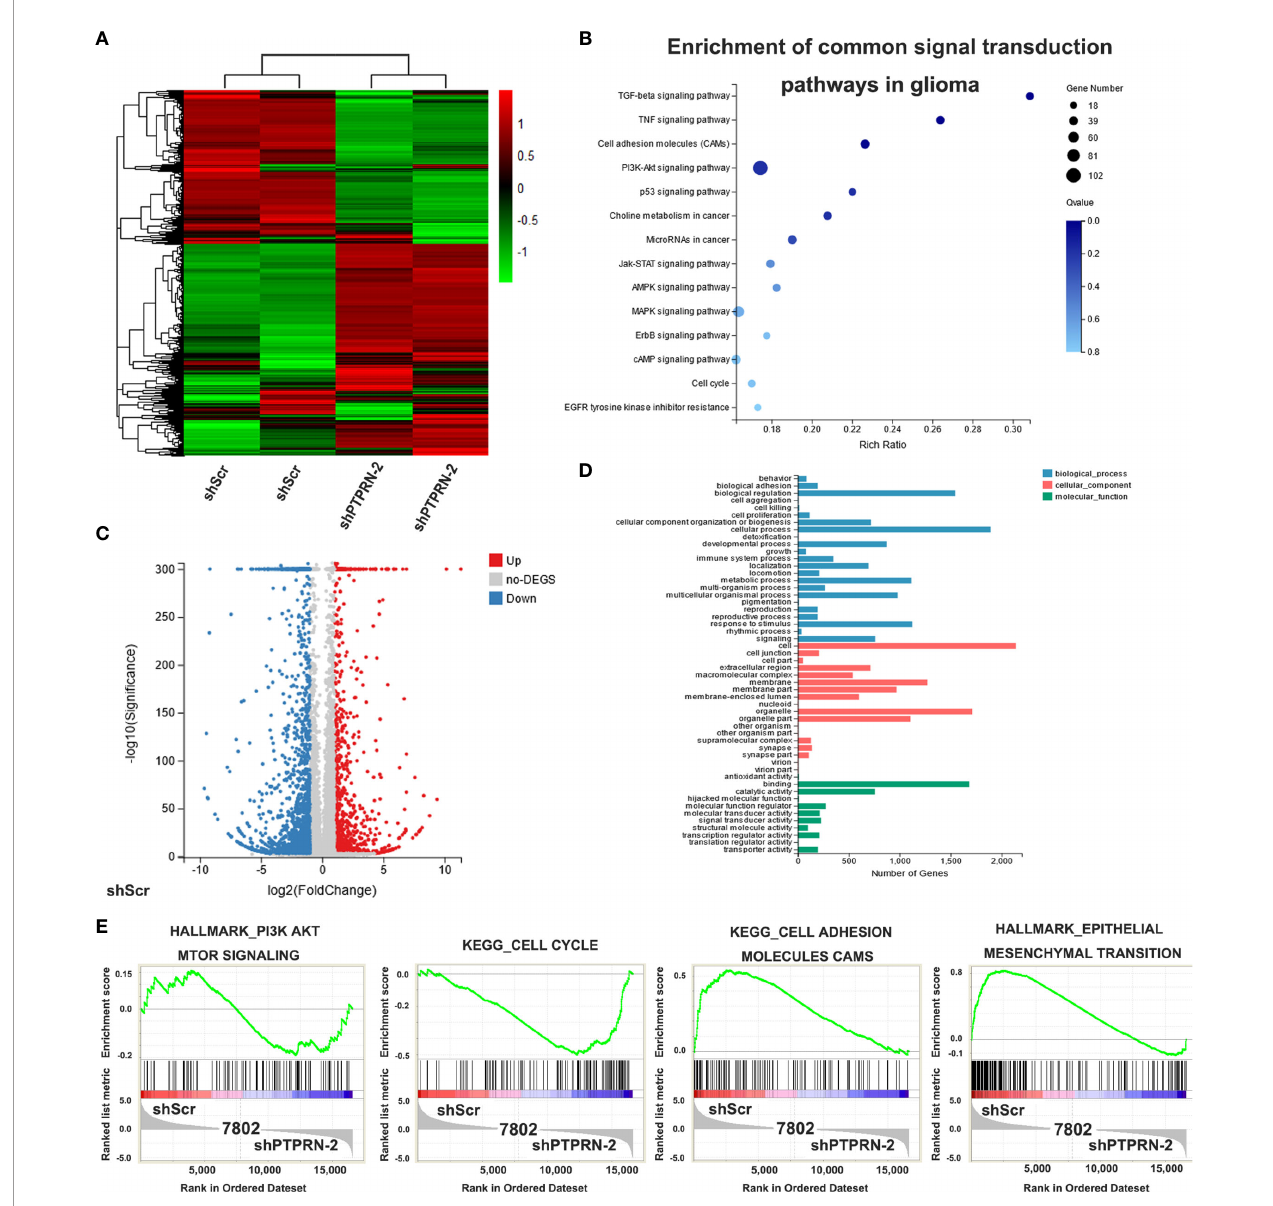
FIGURE 4 | Effect of PTPRN knockdown on the transcriptome of U87 glioma cells. (A) Heat map of differentially expressed genes in shPTPRN U87 glioma cells; red represents highly expressed genes, and the green represents genes with low expression; the expression level is directly proportional to the color depth; (B) the KEGG method was used to analyze the differential genes and to select the enrichment pathways; (C) Volcano plot analysis; red represents highly expressed genes, and blue represents genes with low expression; the expression level is directly proportional to the color depth; (D) Gene Ontology analysis showed differential genes were categorized into three groups, including biological process, cellular component and molecular function; (E) GSEA was used to select the enrichment